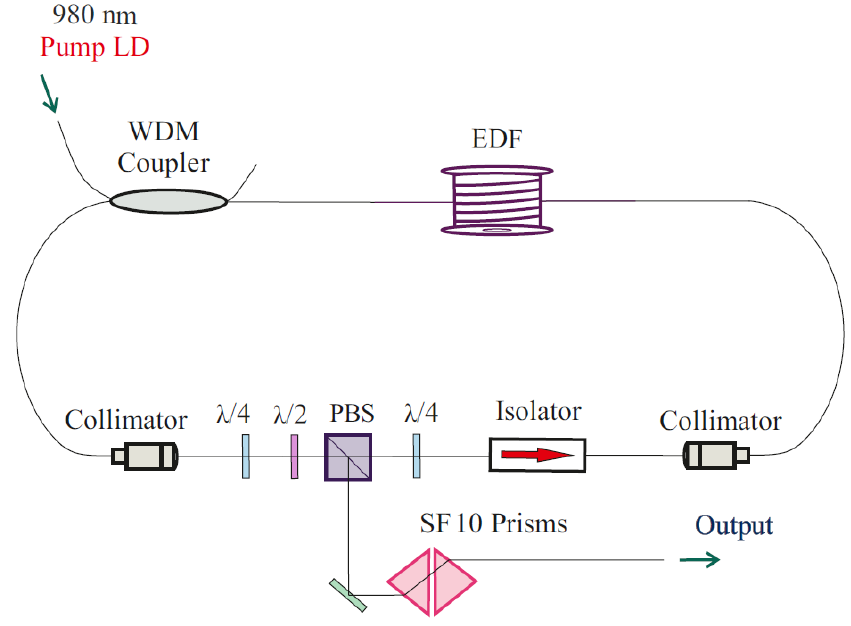
Figure 20. Nonlinear transmission function of an artificial glorifying absorber based on NEP. The phenomenon of rotation of the polarization ellipse concerning intensity was discovered in materials with Kerr nonlinearity in 1965 [178]. The first laser with mode- locking based on this mechanism was implemented in 1972 [179]. The first passively mode-locked fiber laser based on NEP was shown in 1991 [127], where 70 fs pulses were generated in a neodymium fiber laser. Figure 21 shows the schematic of the laser cavity with the shortest pulse duration in an erbium fiber laser to date, using the NEP mechanism [180]. The pulse duration in this laser was 37.4 fs with a pulse repetition rate of 225 MHz. The disadvantages of this scheme include the presence of non-fiber elements in the scheme, which introduce additional losses and require more accurate alignment.